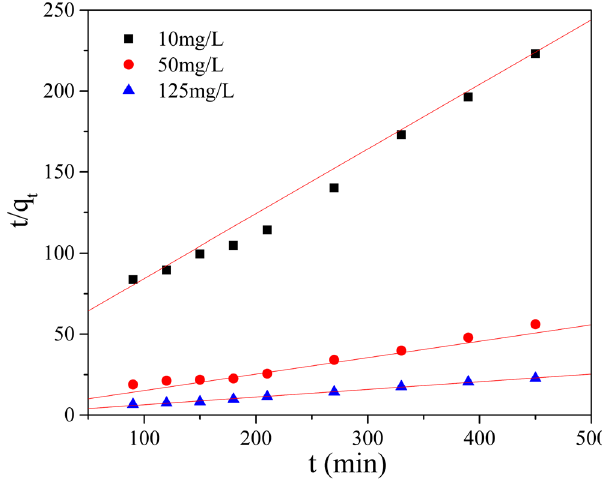
Figure 11. Pseudo -second order reaction